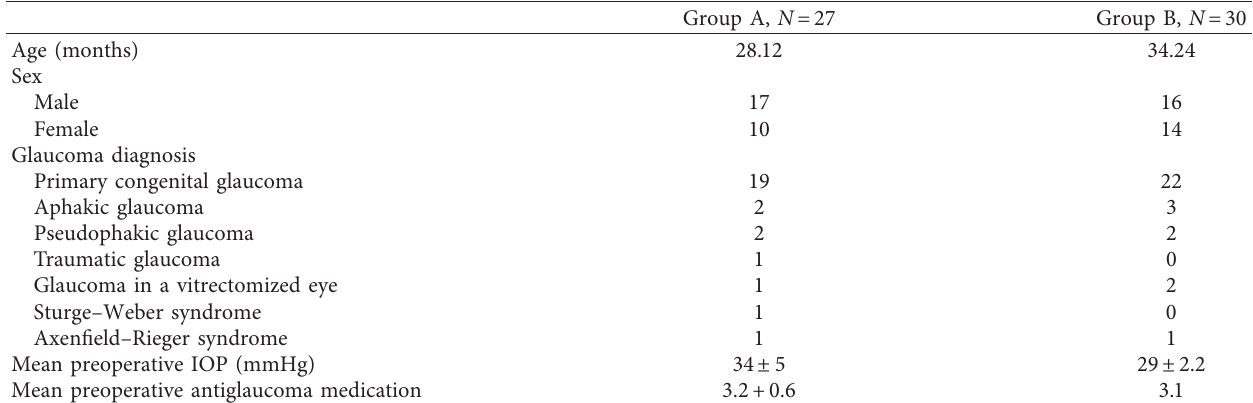
Table 1: Baseline characteristics of the study